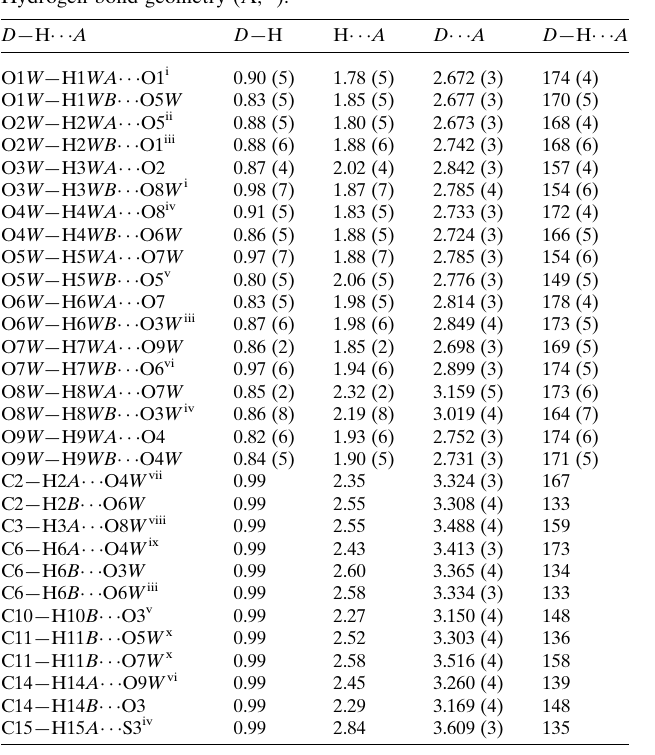
Table 2 Hydrogen-bond geometry (A˚ , (cid:5)